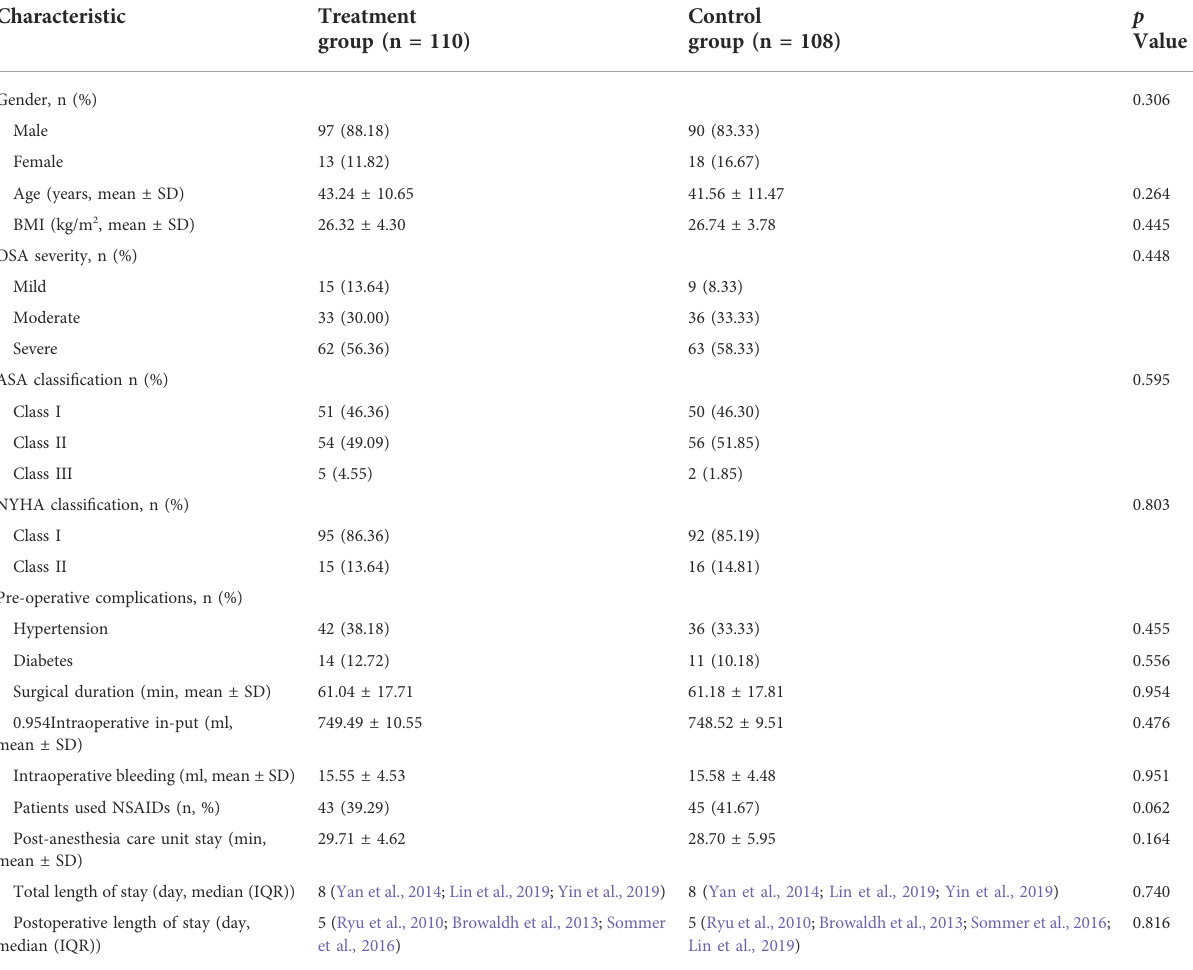
TABLE 1 The characteristics of the patients enrolled in this study.